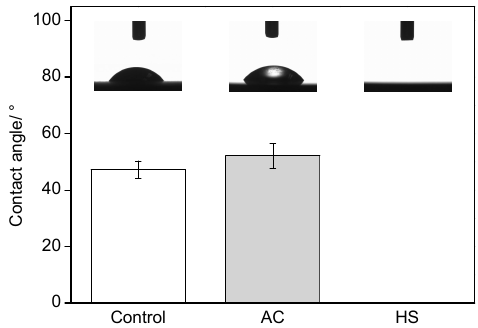
Figure 3. Water contact angles on different specimens.